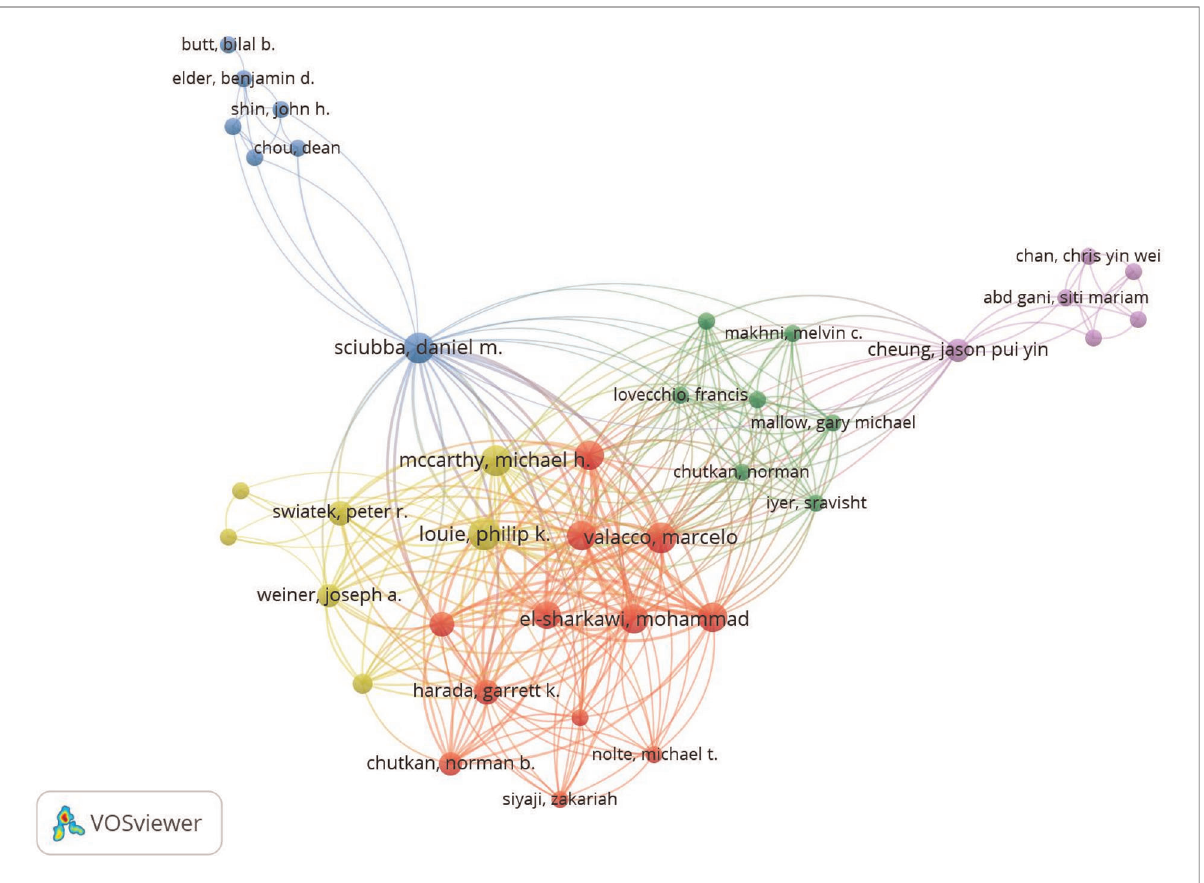
FIGURE 6 Overlay visualization map of author co-authorship